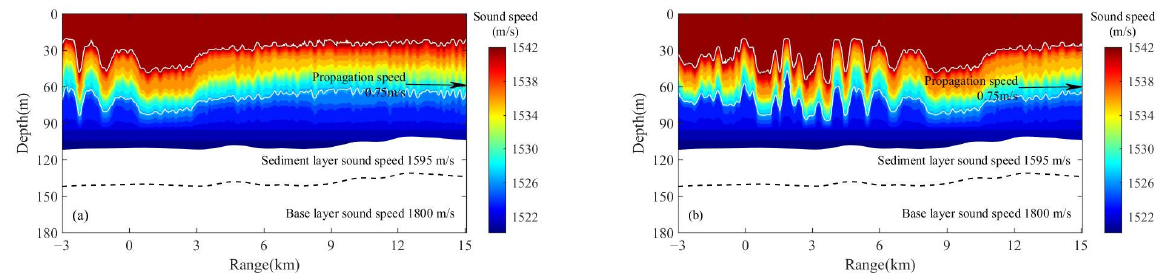
Figure 9. Sound-speed fields constructed for simulation at different times: ( a ) t = 0 and ( b ) t = 2.75 h. The sound-speed fields are measured by the VLA TD sensors at point R. Figure 9. Sound ‐ speed fields constructed for simulation at different times: ( a ) 𝑡 = 0 and ( b ) 𝑡 = 2.75 h. The sound ‐ speed fields are measured by the VLA TD sensors at point R.